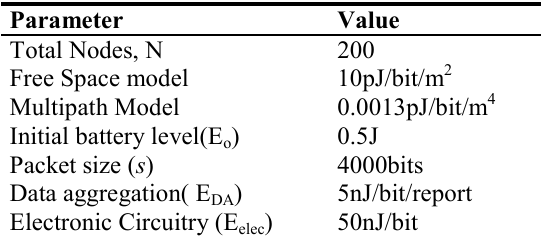
Table 1 . Configuration of Simulation